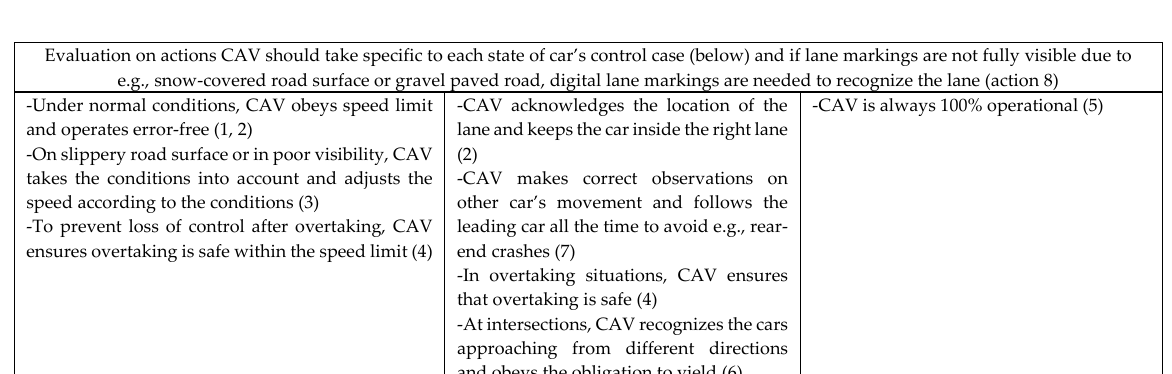
Figure 3. The linkage between the immediate risk factors and the state of a car’s control in a pre-crash event, and a description of potentially needed features and actions to prevent crashes by CAVs with different combinations of the immediate risk factors and pre-crash events.